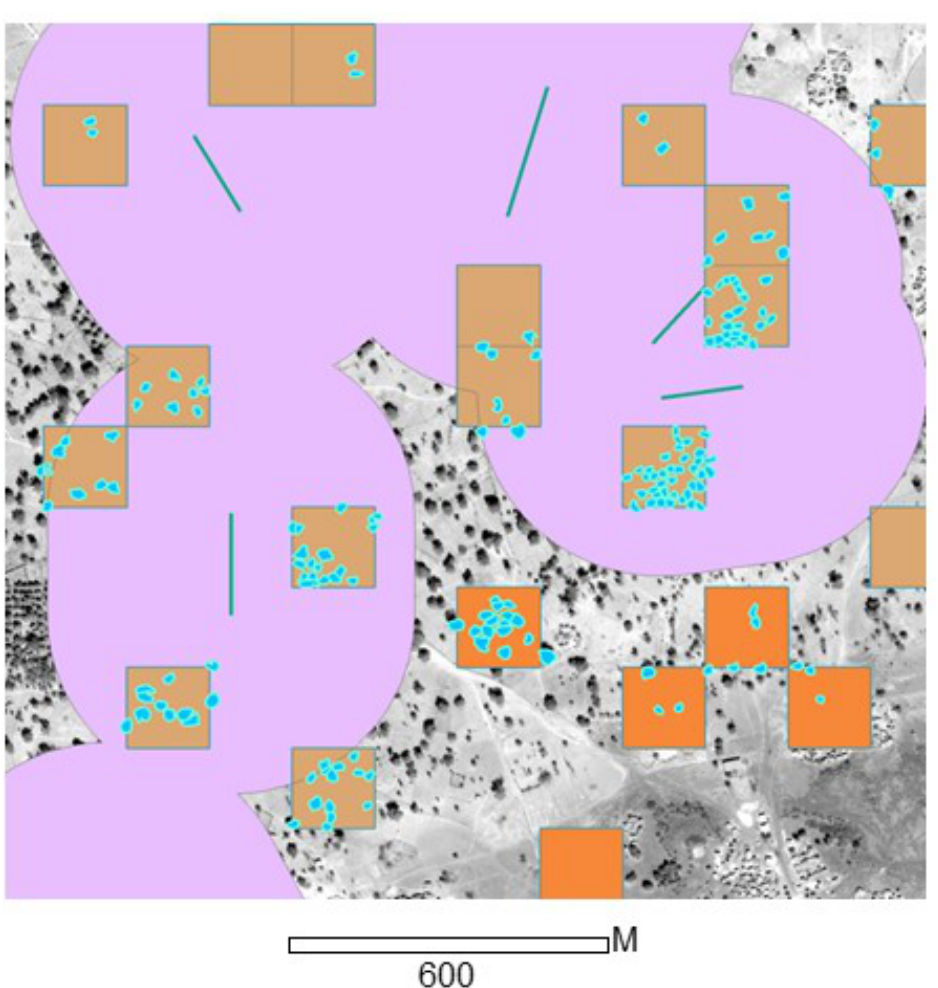
Figure 9. Example of sampling grids (orange squares), dams (blue lines), SWC buffers (purple polygons), and trees (blue and trees (blue polygons).